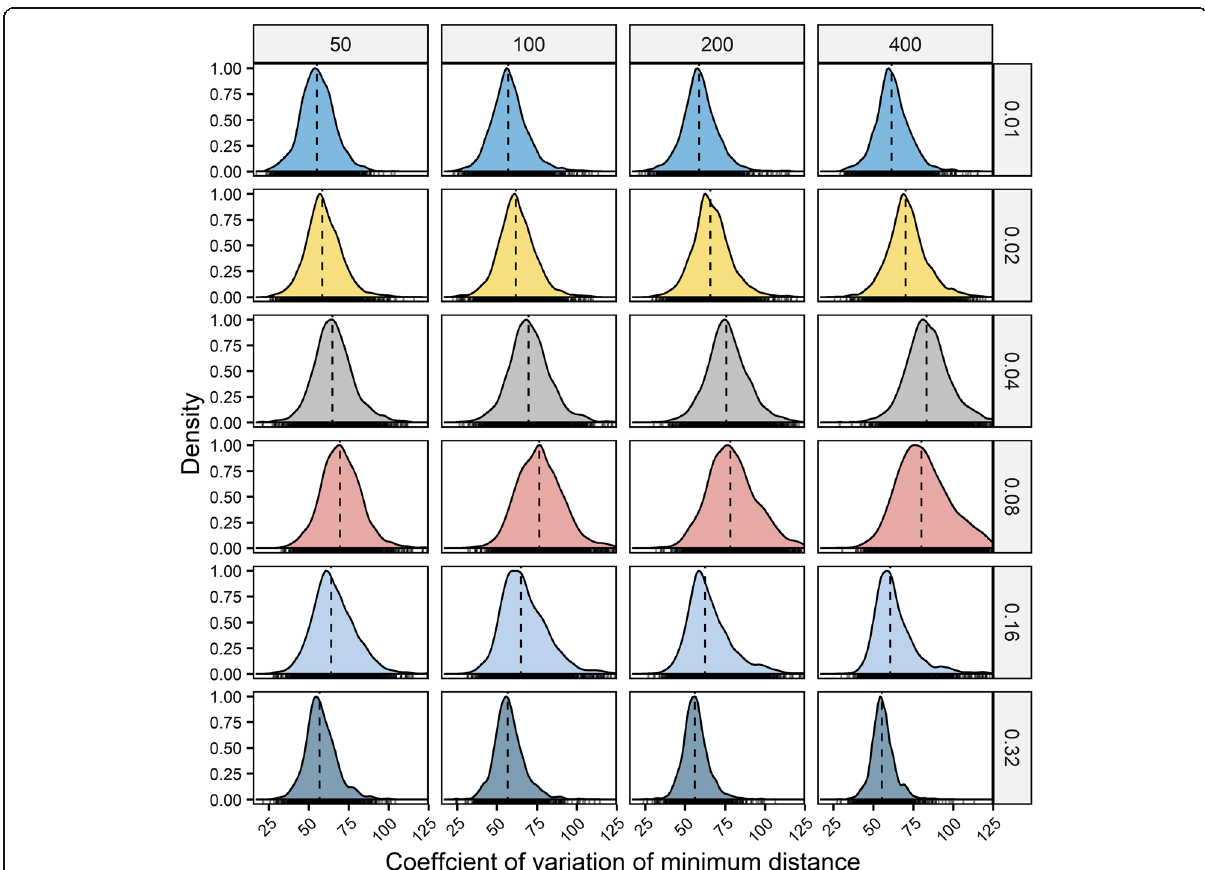
Fig. 2 The density of the coefficient of variance (CV) of the distance between a single pathogen propagule and its nearest BCA propagule in a given simulation run for each combination of biocontrol abundance (50, 100, 200, 400) and aggregation (0.01, 0.02, 0.04, 0.08, 0.16, 0.32) in a homogeneous simulation area. The dashed line indicates the median